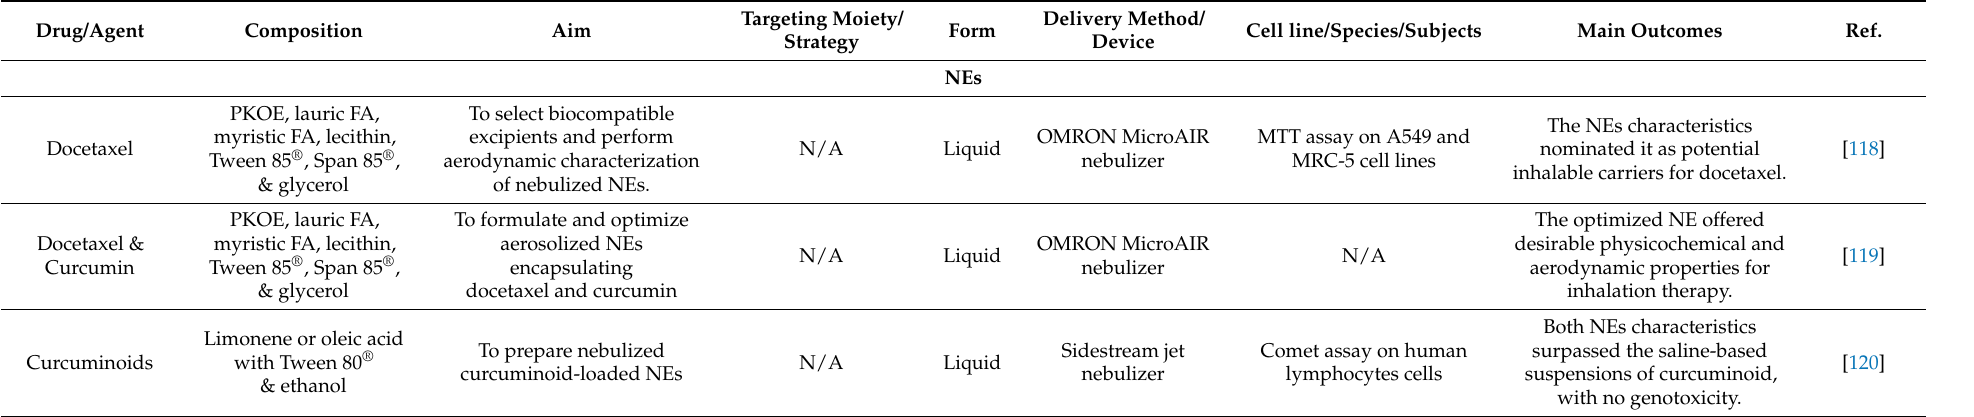
Table 2. Summary of all the published preclinical studies on the developed anticancer drugs-loaded lipid-based nanocarriers for the treatment of